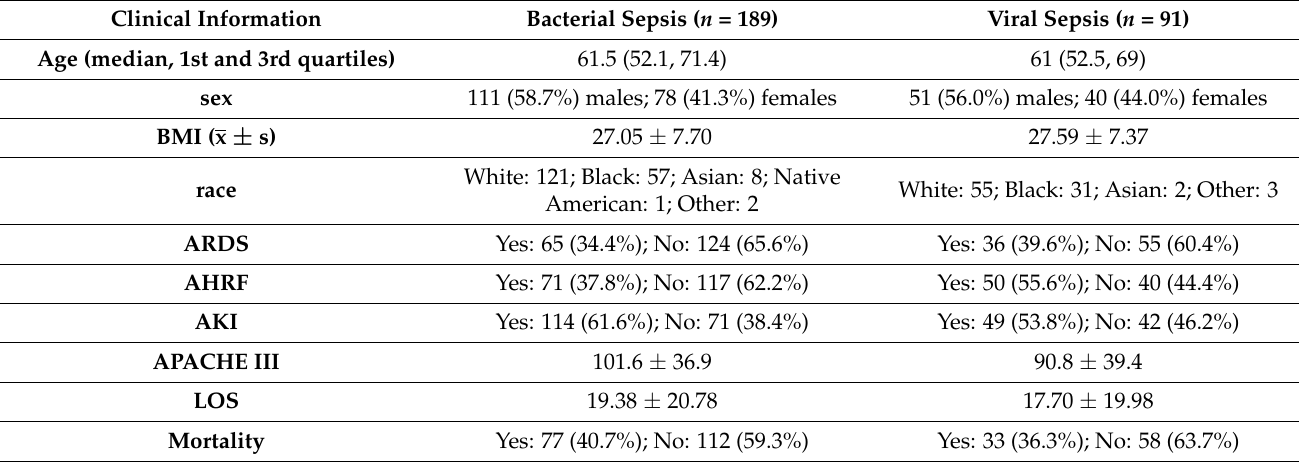
Table 1. Clinical characteristics of the research